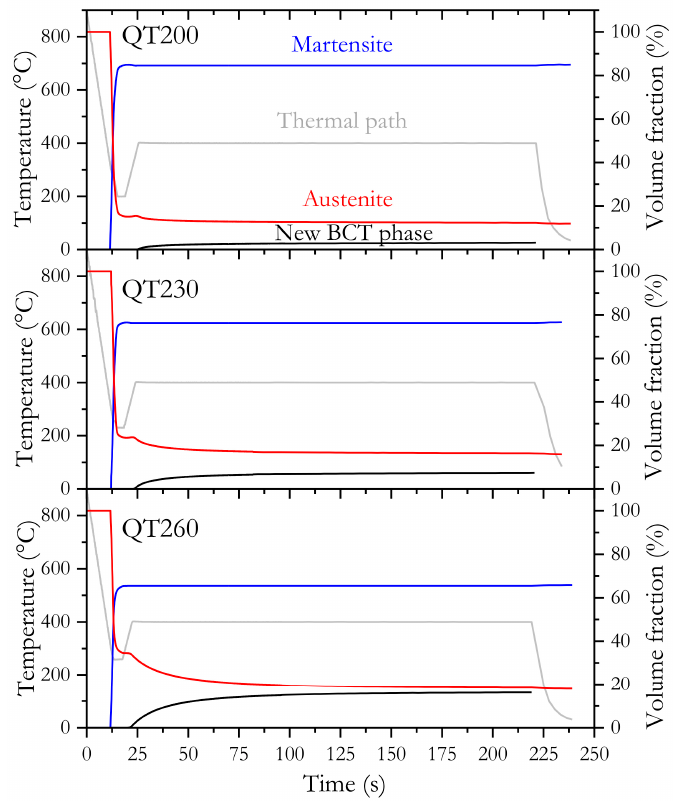
Figure 5. Evolution of the phase fraction during the Q&P treatment for the three QTs